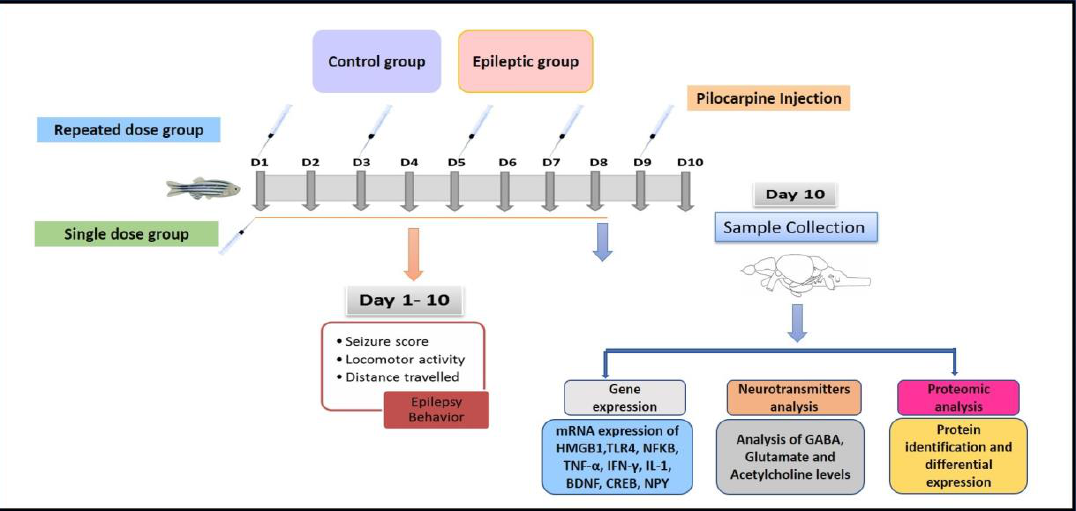
Figure 1. Experimental flowchart elucidating the working protocol.